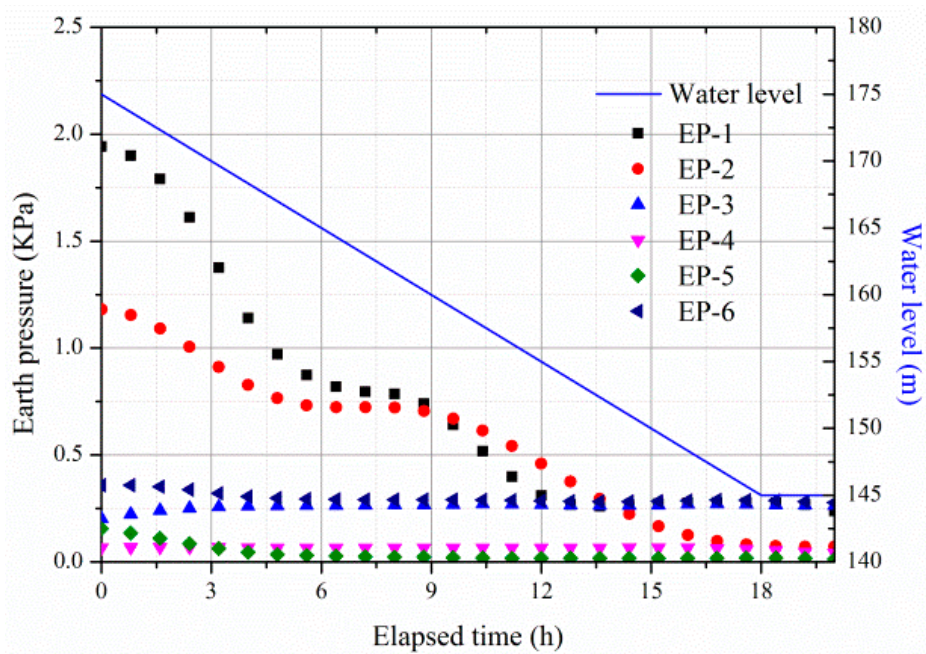
Figure 11. Soil pressure during the water level lowering process.